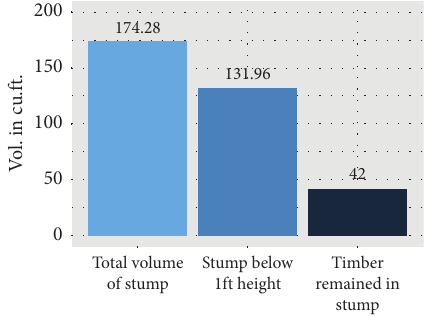
Figure 9: Volume of timber remaining in old